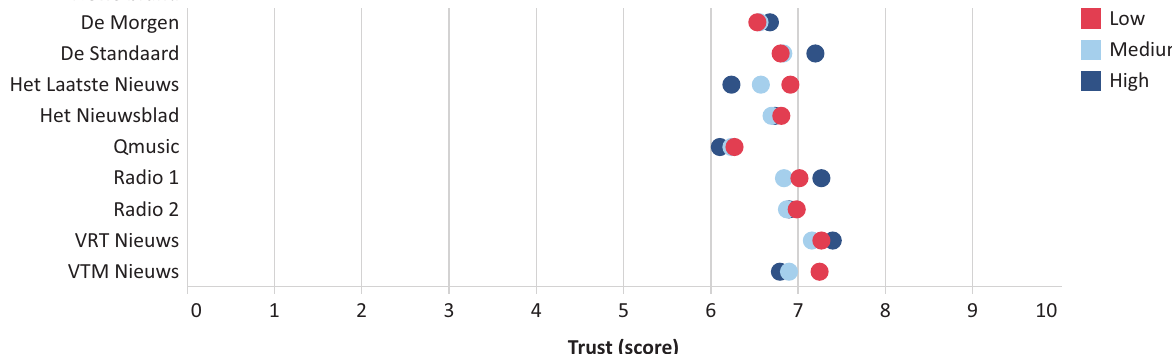
Figure 2. Trust in news brands by education level. Notes: The question was ‘How trustworthy would you say news from the following brands is? Please use the scale below, where 0 is “not at all trustworthy” and 10 is “completely trustworthy.”’See Table 2 in Supplementary File Annex 2 for exact numbers and statistical significance